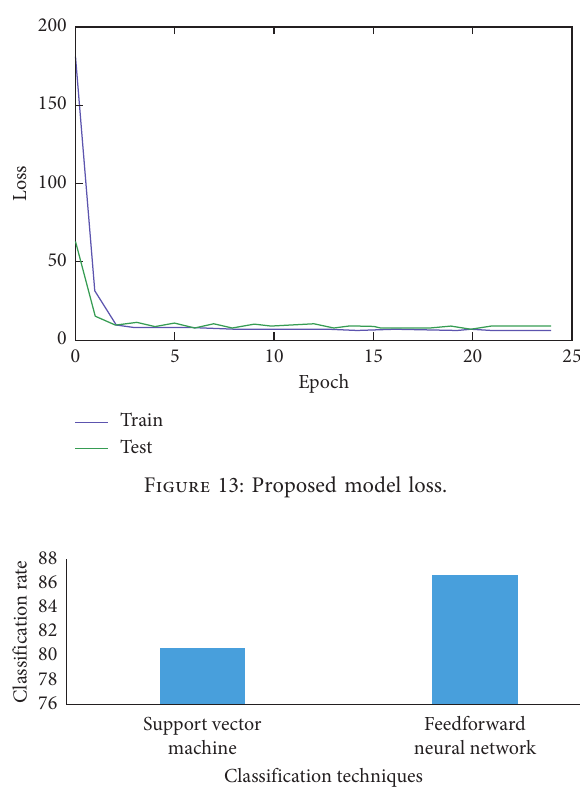
Figure 14: Classification results of the SVM and FNN